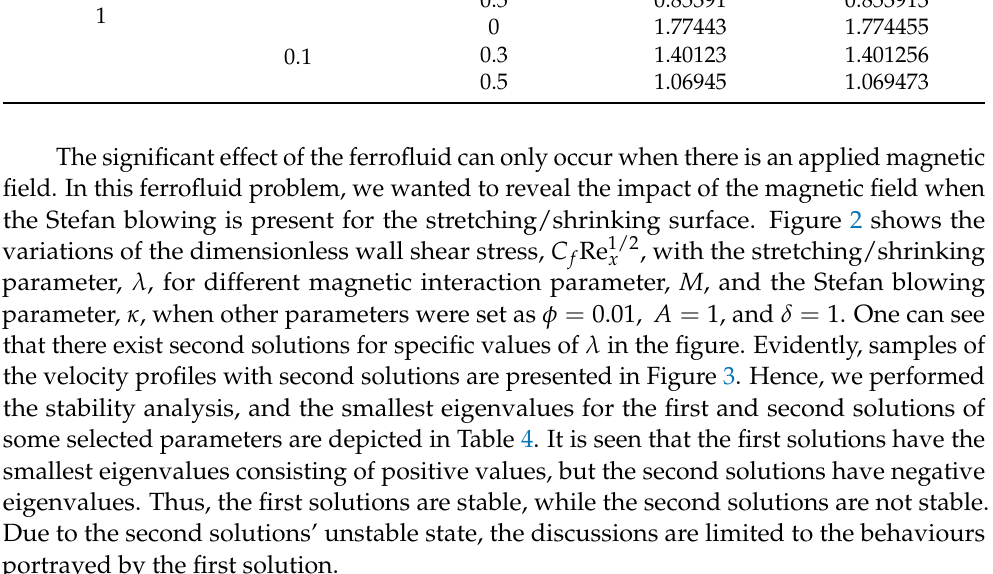
Figure 3. Velocity profiles for different M when 0 01 1 1 . , , A  = = = , and 1 .  = .